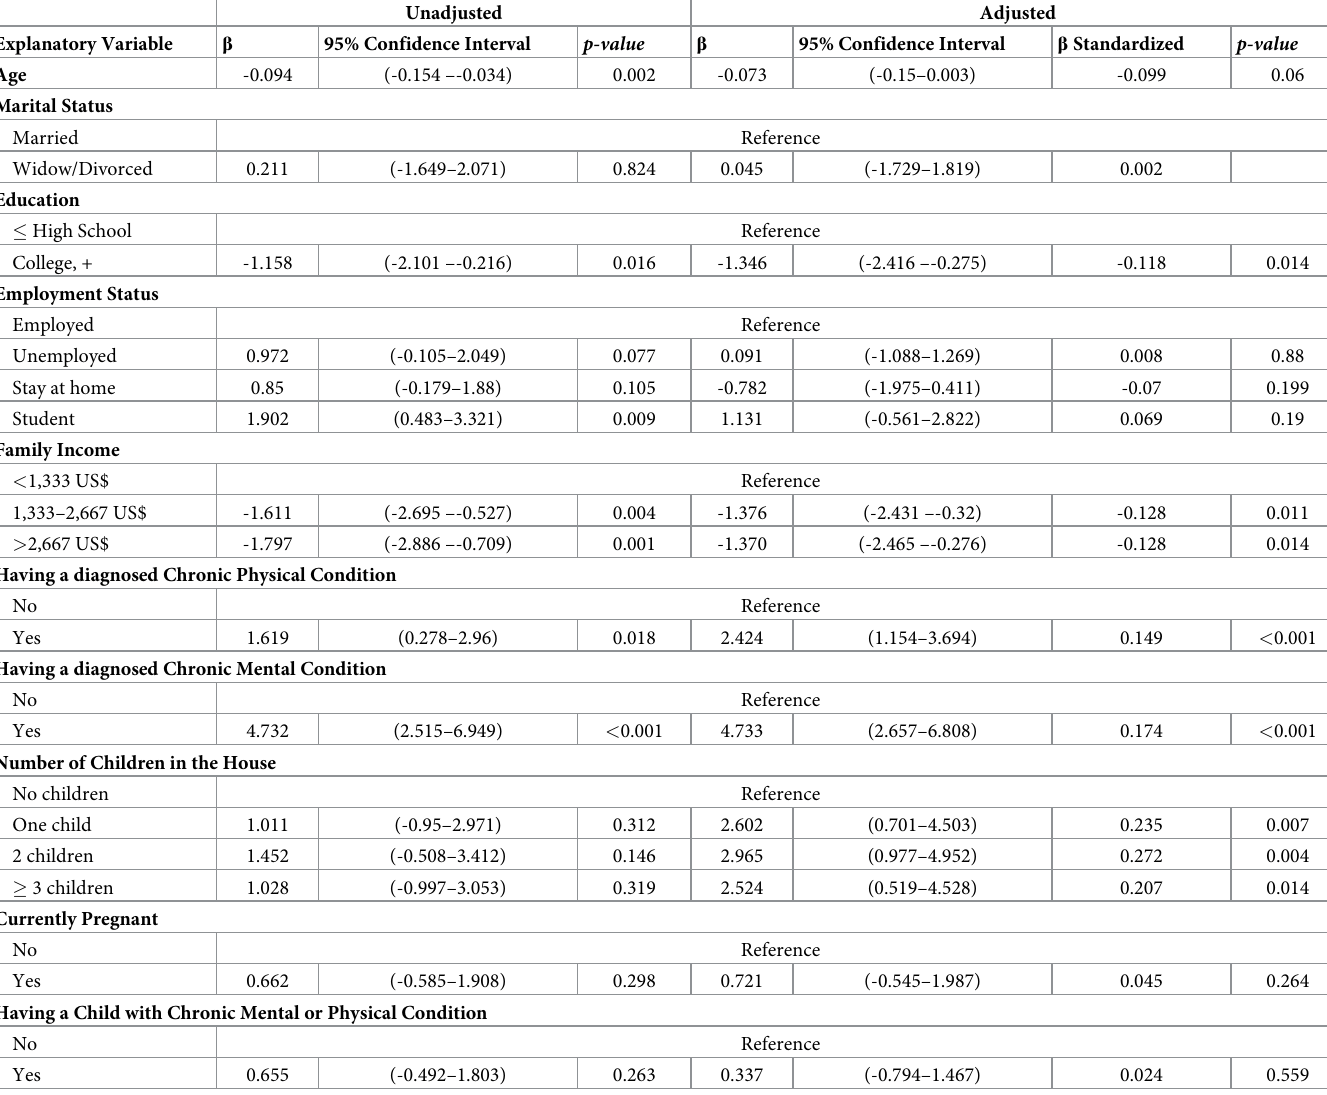
Table 2. Parameter estimates of the explanatory variables from ordinary least squares regression outcome relative to psychological distress. Mothers, and pregnant women ( N =